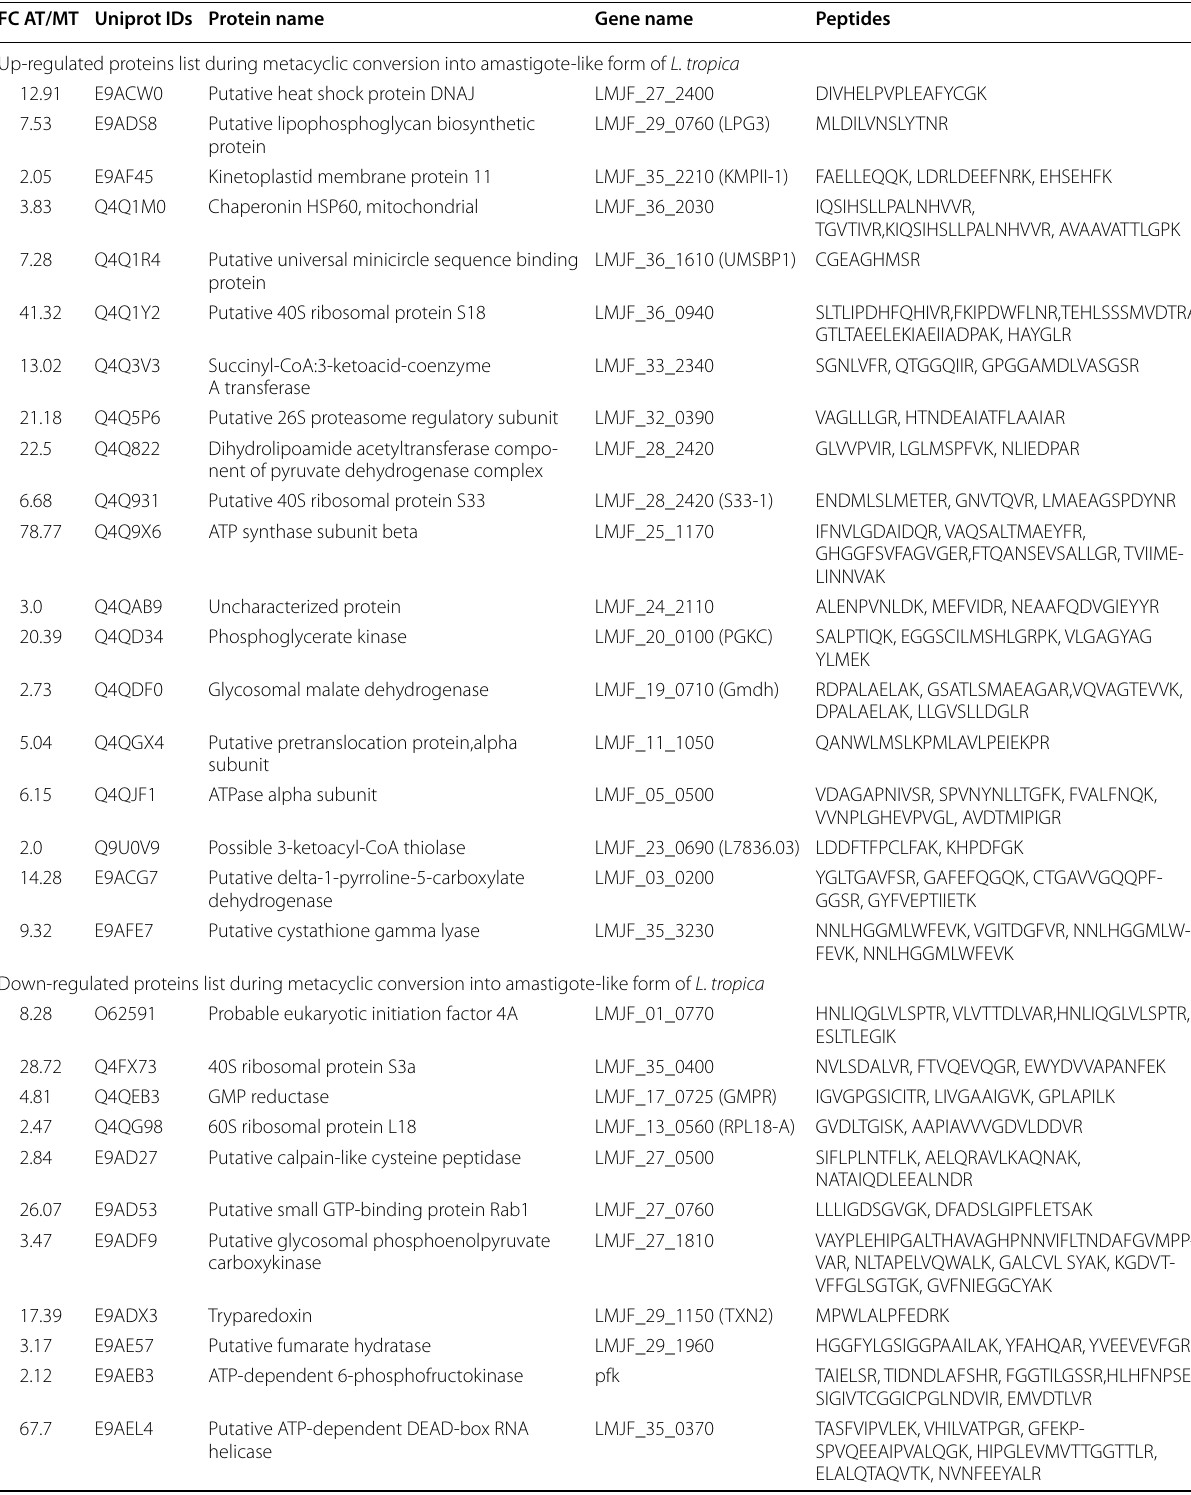
Table 1 The differential expressed proteins in L. tropica metacyclic and amastigote‑like stages FC AT/MT Uniprot IDs Protein name Gene name